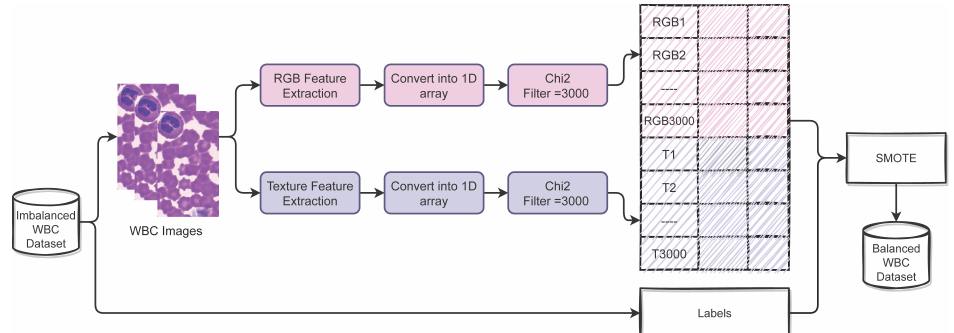
Figure 5. Approach followed for data balance using SMOTE.